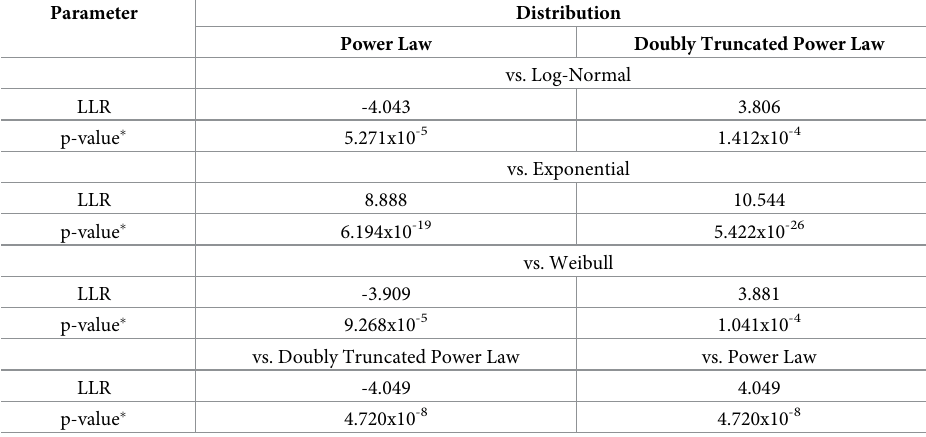
Table 2. Log-likelihood ratio (LLR) comparisons between